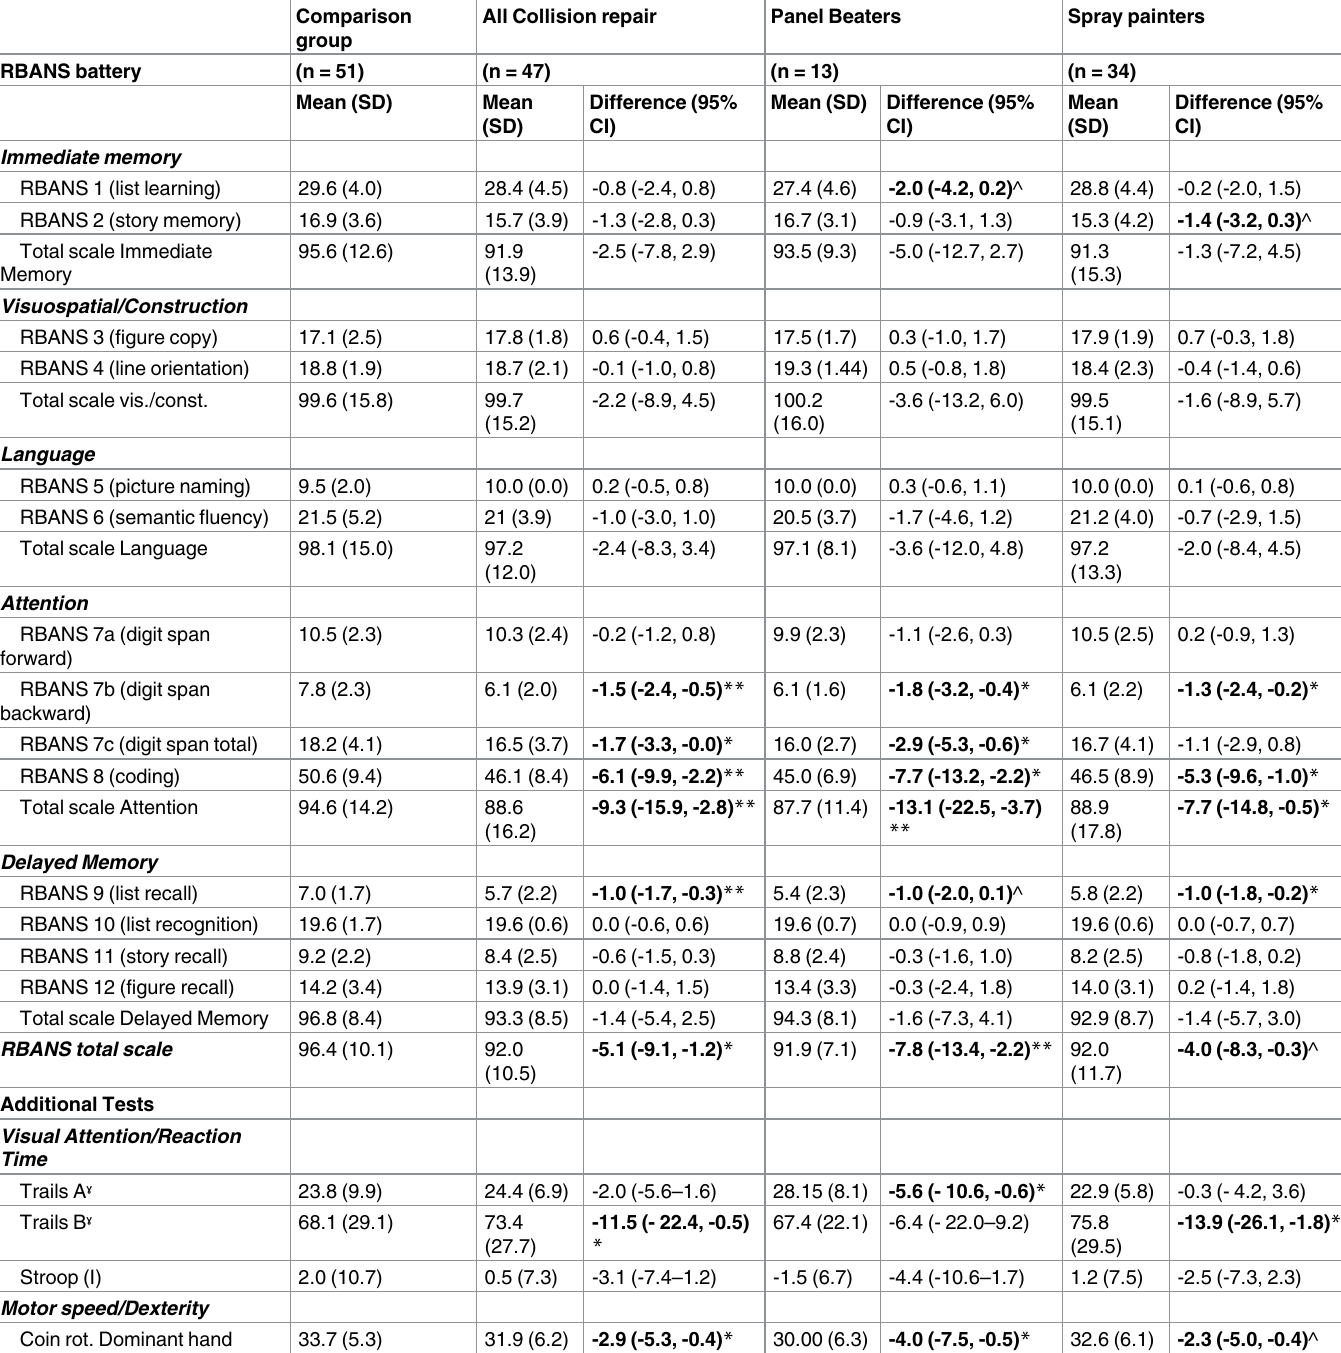
Table 2. Neuropsychological test scores for comparison and collision repair workers. Comparison All Collision repair Panel Beaters Spray group